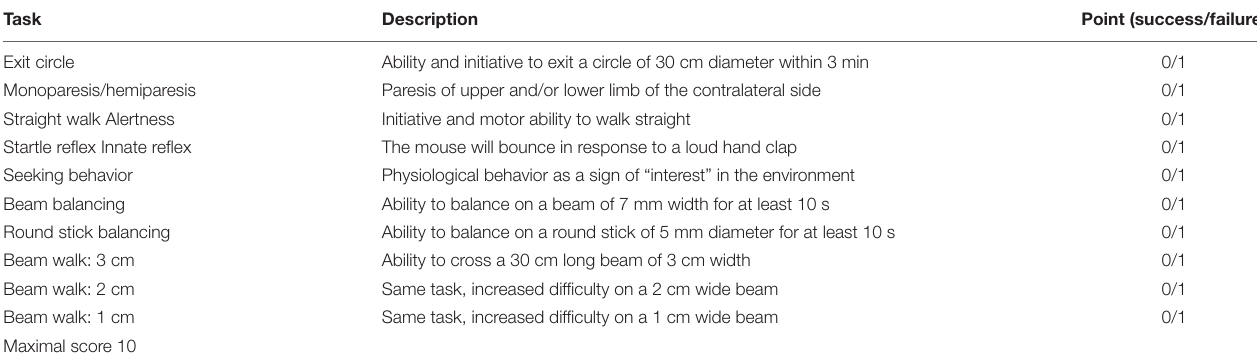
TABLE 1 | Neurologic severity score (NSS).